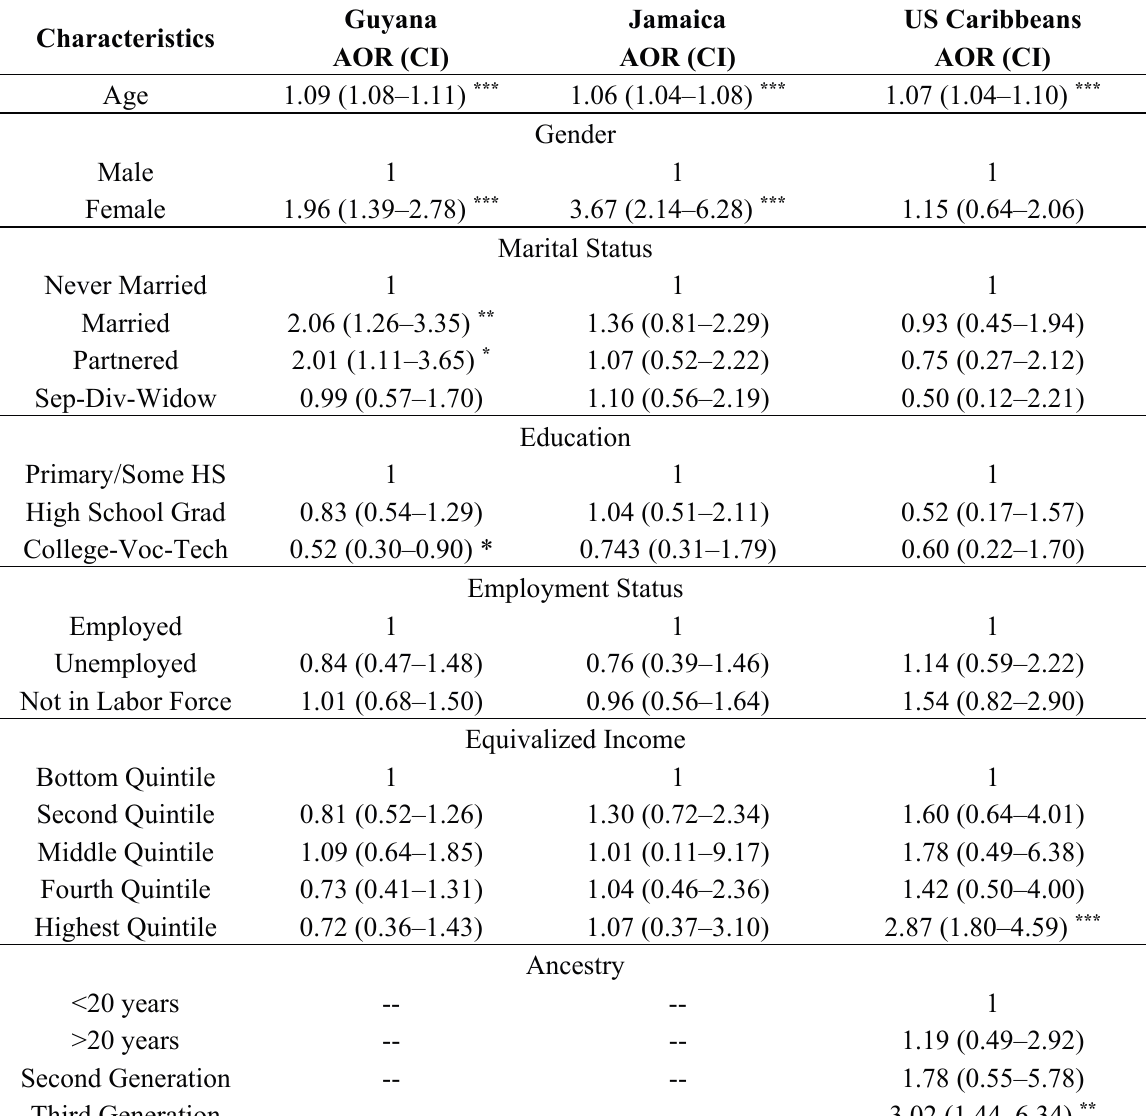
Table 6. Factors associated with lifetime prevalence of hypertension by